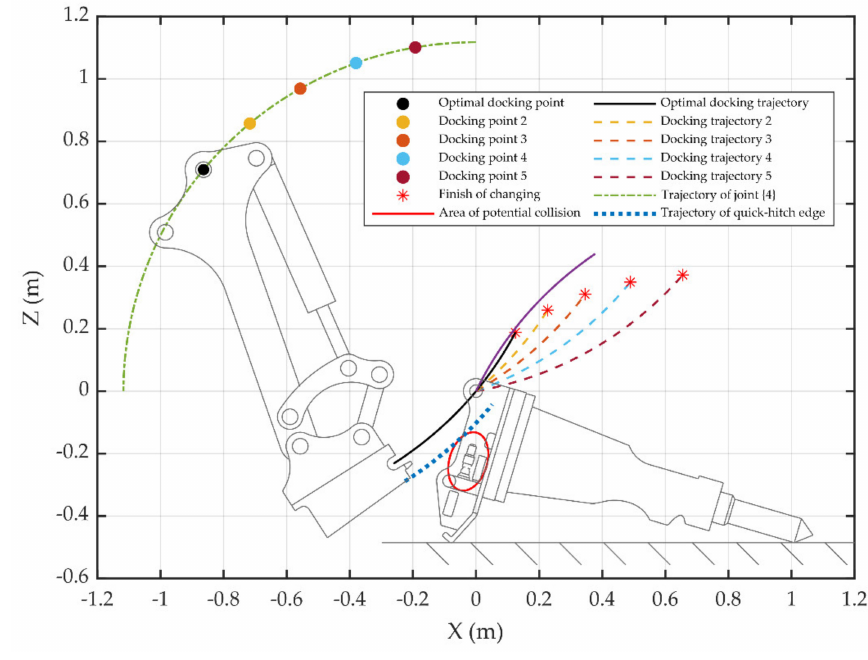
Figure 5. Position determination of joint {4}. Table 2. Data of joint {4} docking